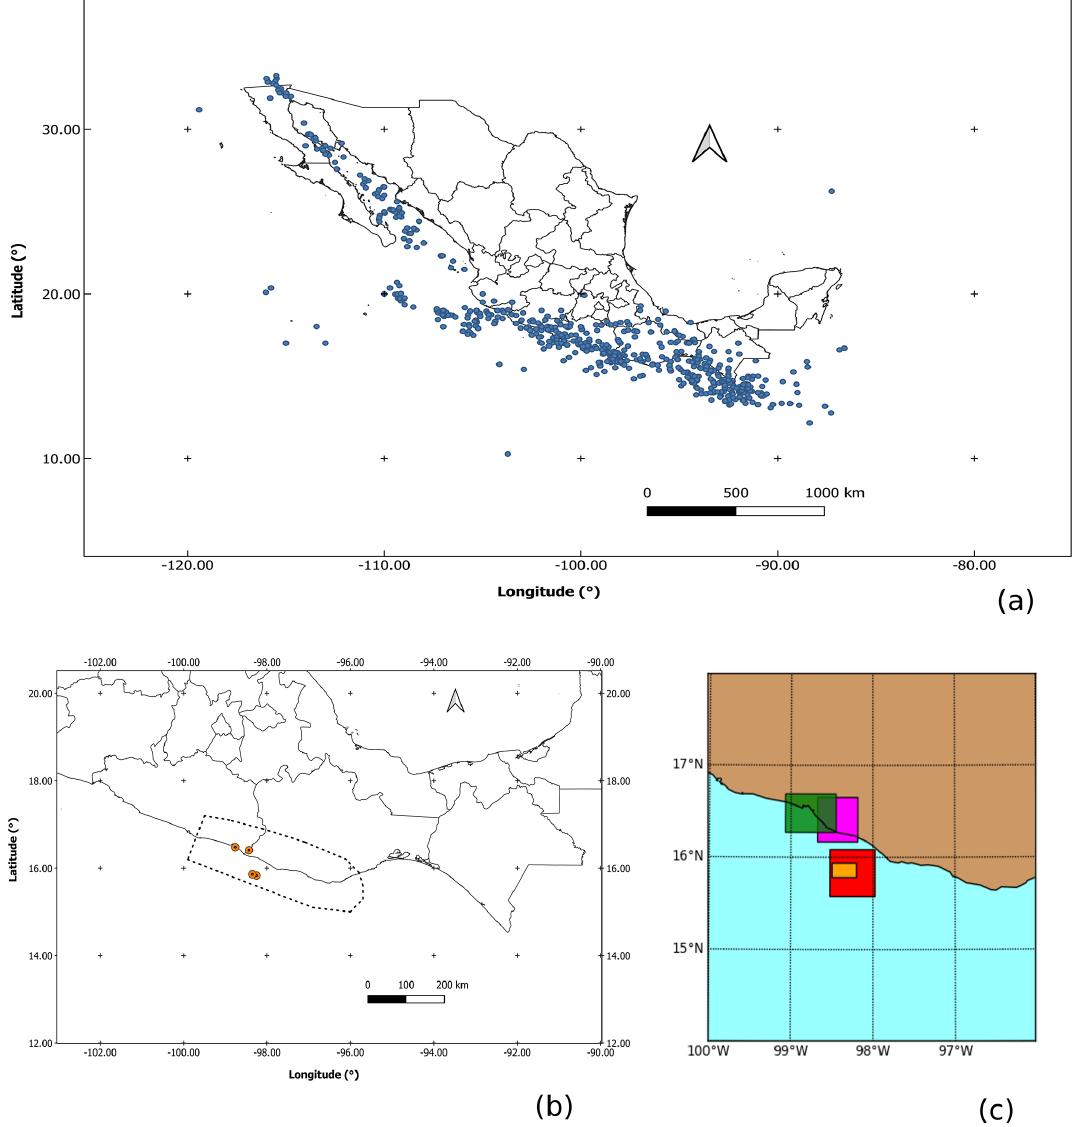
Figure 1. (a) Map of earthquake epicenters in Mexico. From 1900 to 1973, events have magnitudes greater than or equal to 6.5, and from 1974 to 30 June 2019, events have magnitudes greater than or equal to 5.5 (SSN, 2019). (b) Map of epicenters (orange circles) of the four earthquakes described in Table 1. The SUB3 region is the polygon enclosed by the dotted line. (c) Effective areas of the four earthquakes